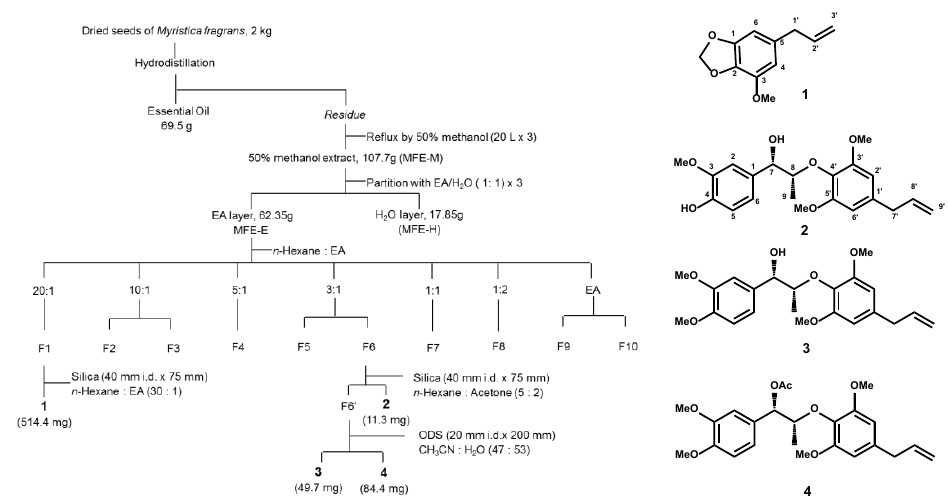
Figure 1. Isolation flowchart of the degreasing of Myristica fragrans using antibacterial bioassay-guided fractionation. The structures of myristicin ( 1 ), (+)- erythro - Δ 8′ -7 S ,8 R - dihydroxy-3, 3′ , 5′ -trimethoxy-8- O - 4′ -neolignan ( 2 ), (+)- erythro- Δ 8′ -7-hydroxy-3,4, 3′ , 5′ -tetramethoxy- 8- O - 4′ -neolignan ( 3 ), and e rythro - Δ 8′ -7-acetoxy-3,4, 3′ , 5′ -tetramethoxy-8- O - 4′ -neolignan ( 4 ) are shown. F1 to F10 indicated different eluted fractions. Table 1. Antibacterial activity of myristicin and three neolignans.